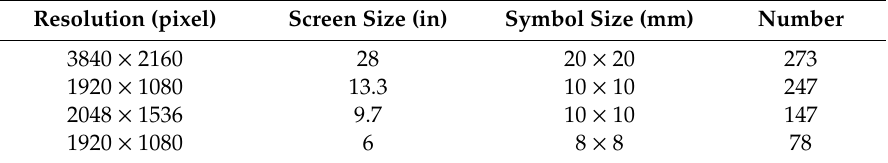
Table 1. Proper numbers calculated by parameters of di ff erent screens and symbol sizes. Resolution (pixel) Screen Size (in) Symbol Size (mm) Number 3840 × 2160 28 20 × 20 273 1920 × 1080 13.3 10 × 10 247 2048 × 1536 9.7 10 × 10 147 1920 × 1080 6 8 × 8